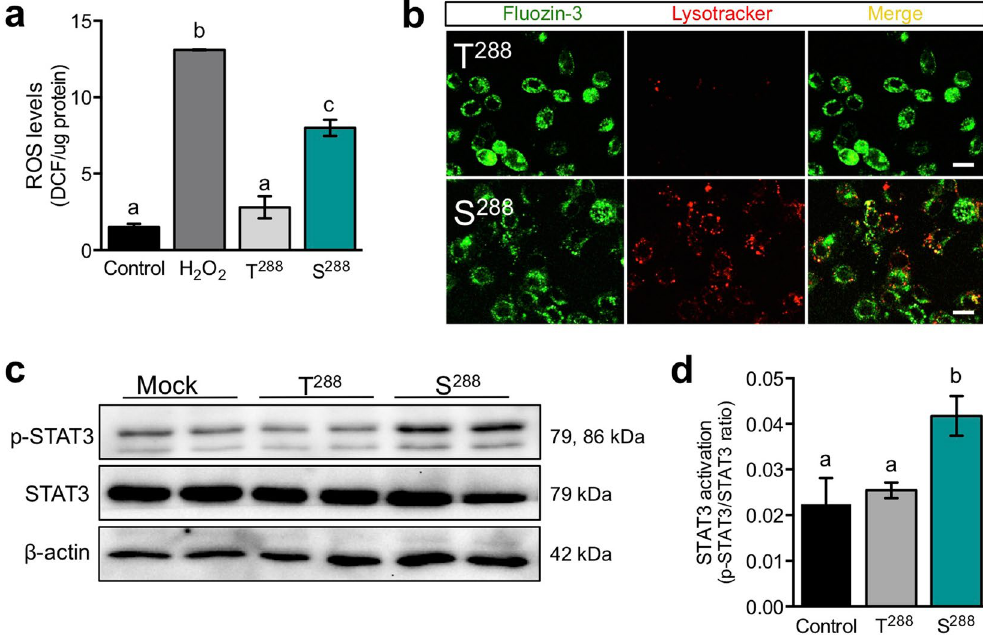
Figure 3. Cells expressing the S 288 variant of ZnT2 have increased oxidative stress, lysosomal activity and STAT3 activation. ( a ) Assessment of reactive oxygen species (ROS) level in untransfected MECs (Control) or MECs transfected to express wild-type ZnT2 (T 288 ) or the ZnT2 variant (S 288 ). Cells treated with H 2 O 2 (100 µ M) were used as a positive control. Data represent mean DCF-HA fluorescence/ µ g of protein ± SD, from n = 6 samples/group; the experiment was repeated three times. Means with different letters are significantly different, p < 0.01. ( b ) Representative confocal images of FluoZin-3 (green) and Lysotracker Red (red) in MECs expressing T 288 or S 288 . Merged images (yellow) illustrate co-localized FluoZin-3 and Lysotracker Red. Note greater Lysotracker Red fluorescence in MECs expressing T 288 compared with MECs expressing S 288 (scale bar, 20 µ m). ( c ) Representative immunoblots of p-STAT3 and total STAT3 in cell lysates from MECs expressing T 288 , S 288 , or mock-transfected (Mock) cells. β -actin served as a loading control. Cropped blots are displayed and full- length blots can be found in Supplementary Fig. S4a–c. ( d ) Quantification of STAT3 activation. Data represent mean p-STAT3/total STAT3 ± SD from n = 6 samples/genotype, from three independent experiments. Means with different letters are significantly different, p <